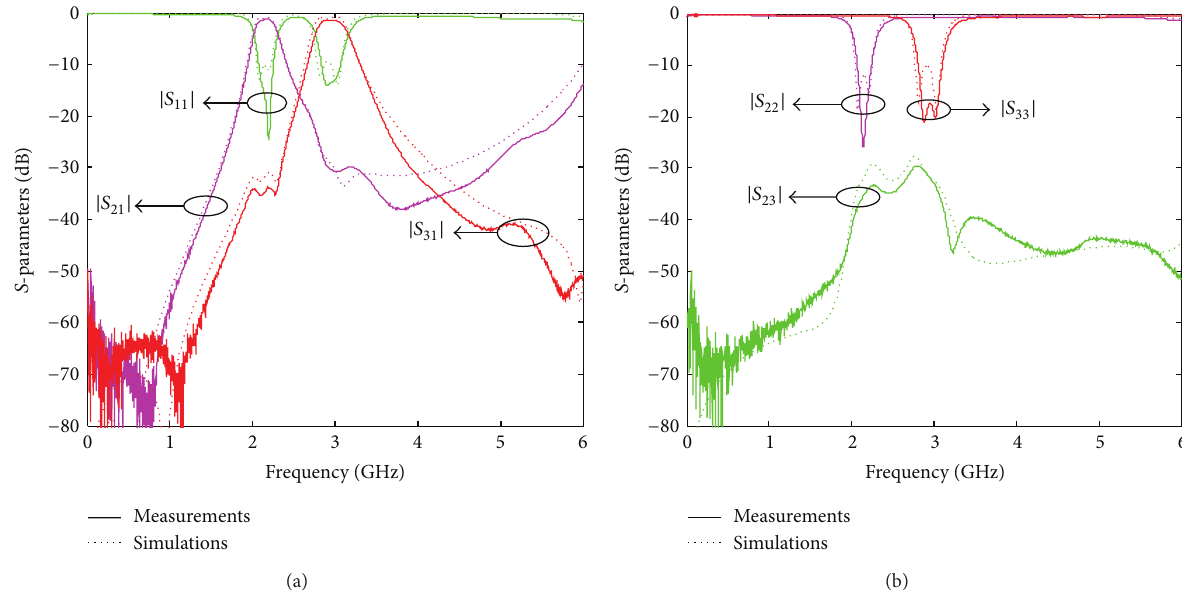
Figure 4: (a) The measured and simulated reflections of Port 1 and transmissions of Ports 2 and 3 from Port 1 and (b) reflection for Ports 2 and 3 and the transmission between Ports 2 and 3. Table 1: Comparisons between the proposed diplexer and other compact designs.